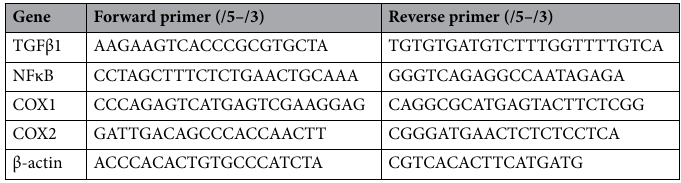
Table 2. Forward and reverse primers sequence for real time